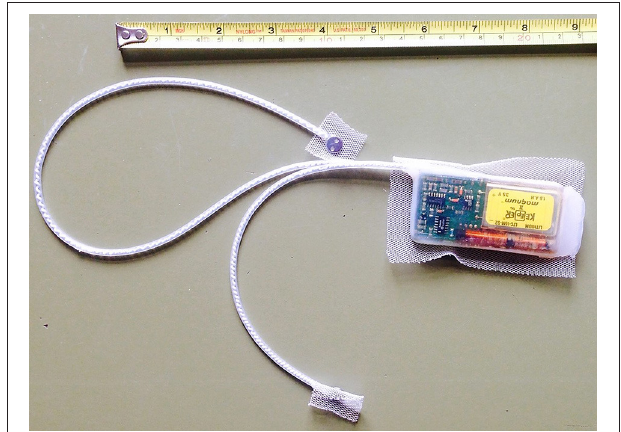
FIGURE 1 | Photograph showing the self-constructed transmitter with the two electrode plates. We implanted the transmitter under the skin of the left side of the neck. Electrodes were placed next to the